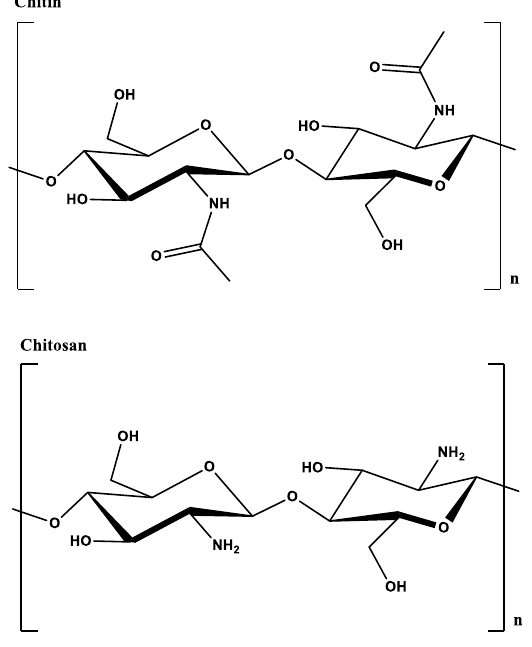
Figure 1. Structure of chitin and chitosan.